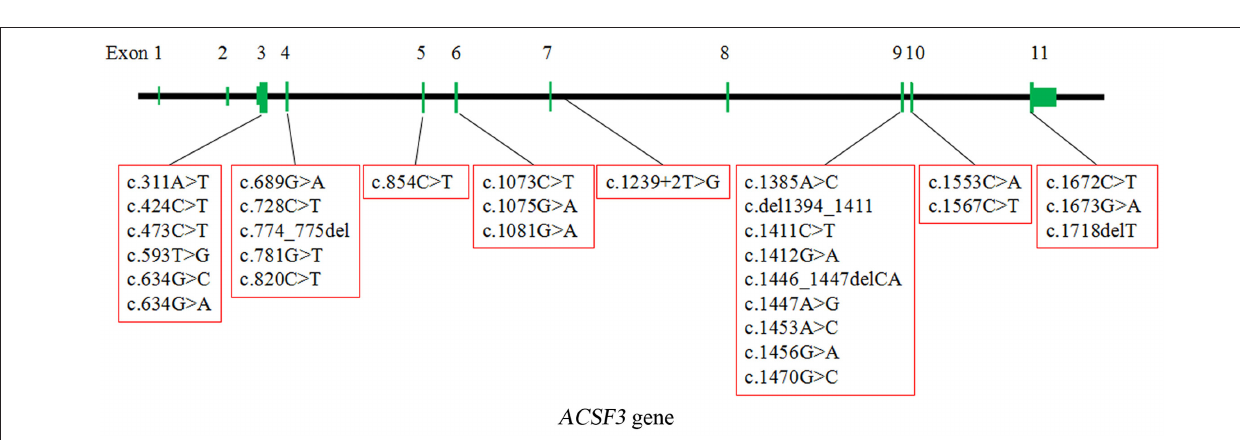
population) in UPB1 gene could be asymptomatic as well